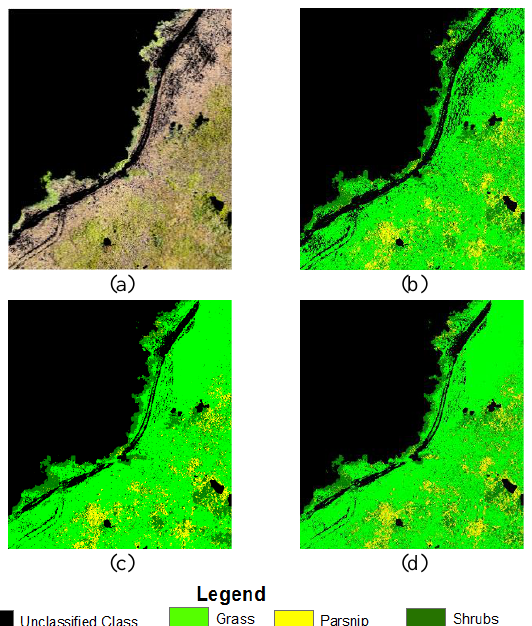
Figure 6. Pixel-based classification result: (a) UAV Masked Image (0.03 m resolution), (b) RF, (c) SVM, (d) ML